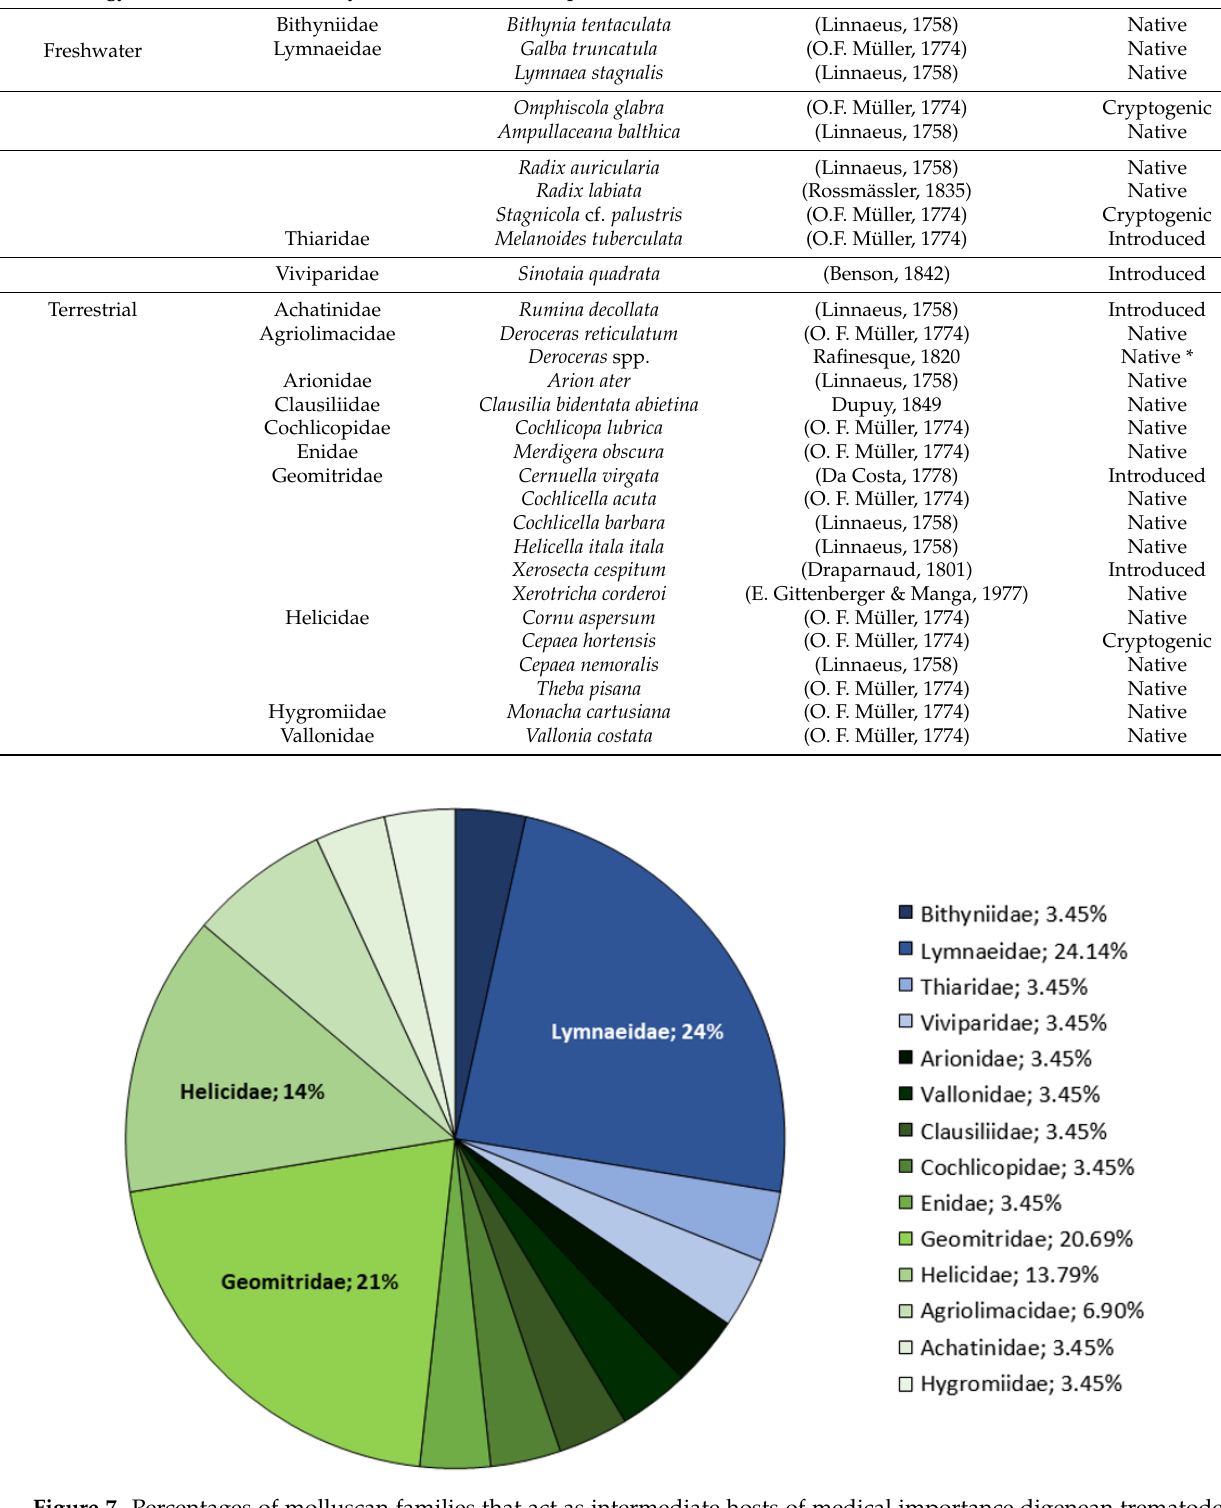
Figure 7. Percentages of molluscan families that act as intermediate hosts of medical importance digenean trematodes. Families of freshwater molluscs in blue colour and the families of terrestrial molluscs in green colour.